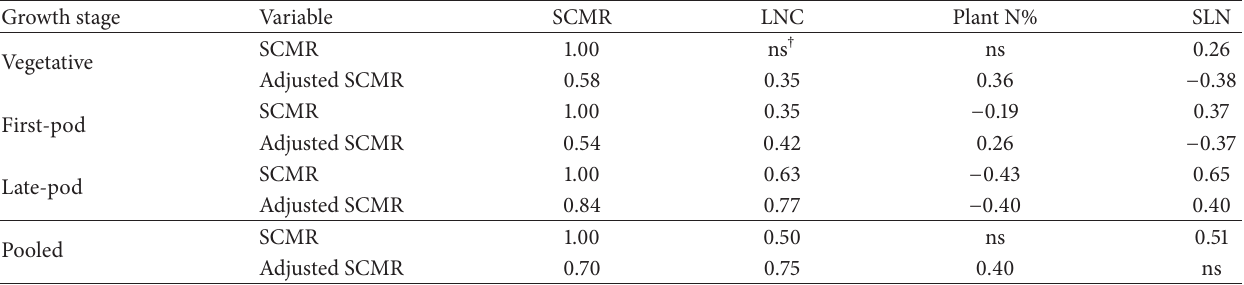
Table 3: Correlation coefficients of SCMR and adjusted SCMR (SCMR/SLW) with leaf N concentration (LNC), plant N concentration (plant N), and specific leaf N (SLN) for each growth stage of vegetative, first-pod, and late-pod and for the pooled data over the growth stages.